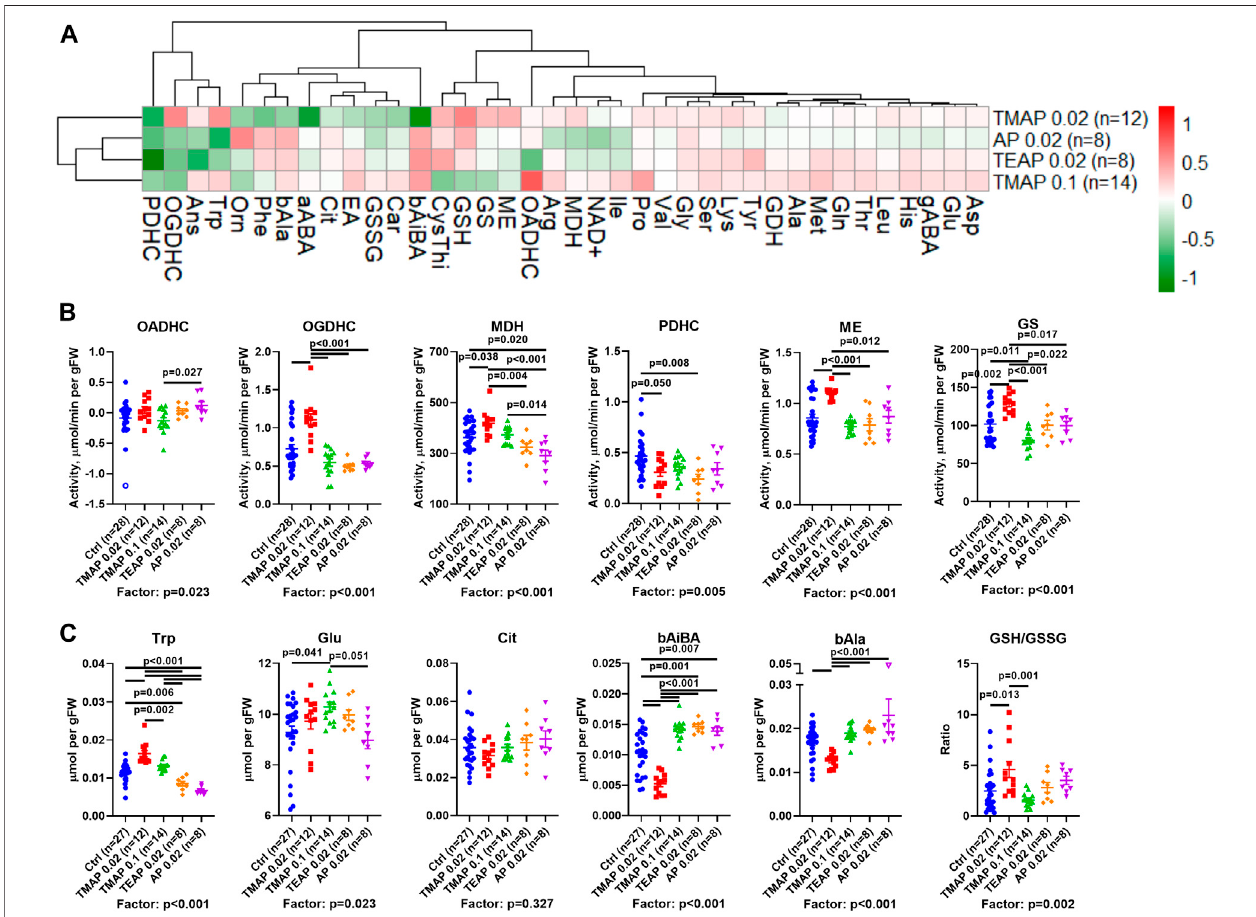
FIGURE4| Effectsofadipoylphosphonate(AP)anditstrimethyl(TMAP)andtriethyl(TEAP)estersonbiochemicalindicatorsintheratcerebralcortex. (A) Heatmap of the inhibitor-induced changes in the levels of metabolites and enzymatic activities, presented as log2 of the fold-change in the treated animals, compared to the non- treated ones. (B) Statistical analysis of the group differences in the activities of selected enzymes. (C) Statistical analysis of the group differences in the levels of metabolites. Signi fi cant ( p ≤ 0.05) differences between the experimental groups, estimated by ANOVA with Tukey ’ s post hoc test, are indicated on the graphs. ANOVA p -values for the treatment factor signi fi cance are shown below the graphs. Hollow points show outliers according to the iterative Grubb ’ s test, excluded from statistical analysis. The indicated number of animals in experimental groups ( n ) includes outliers. Proteinogenic amino acids are abbreviated according to the standard three-letter code. Other abbreviations used are given in the Abbreviations section.